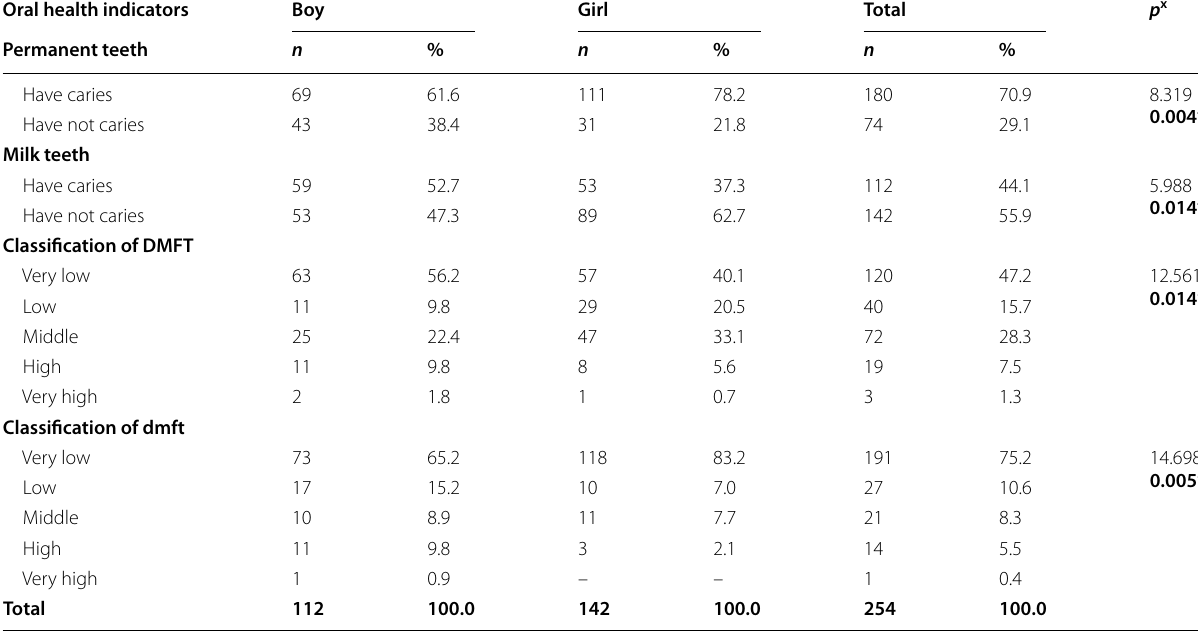
x Chi-square test